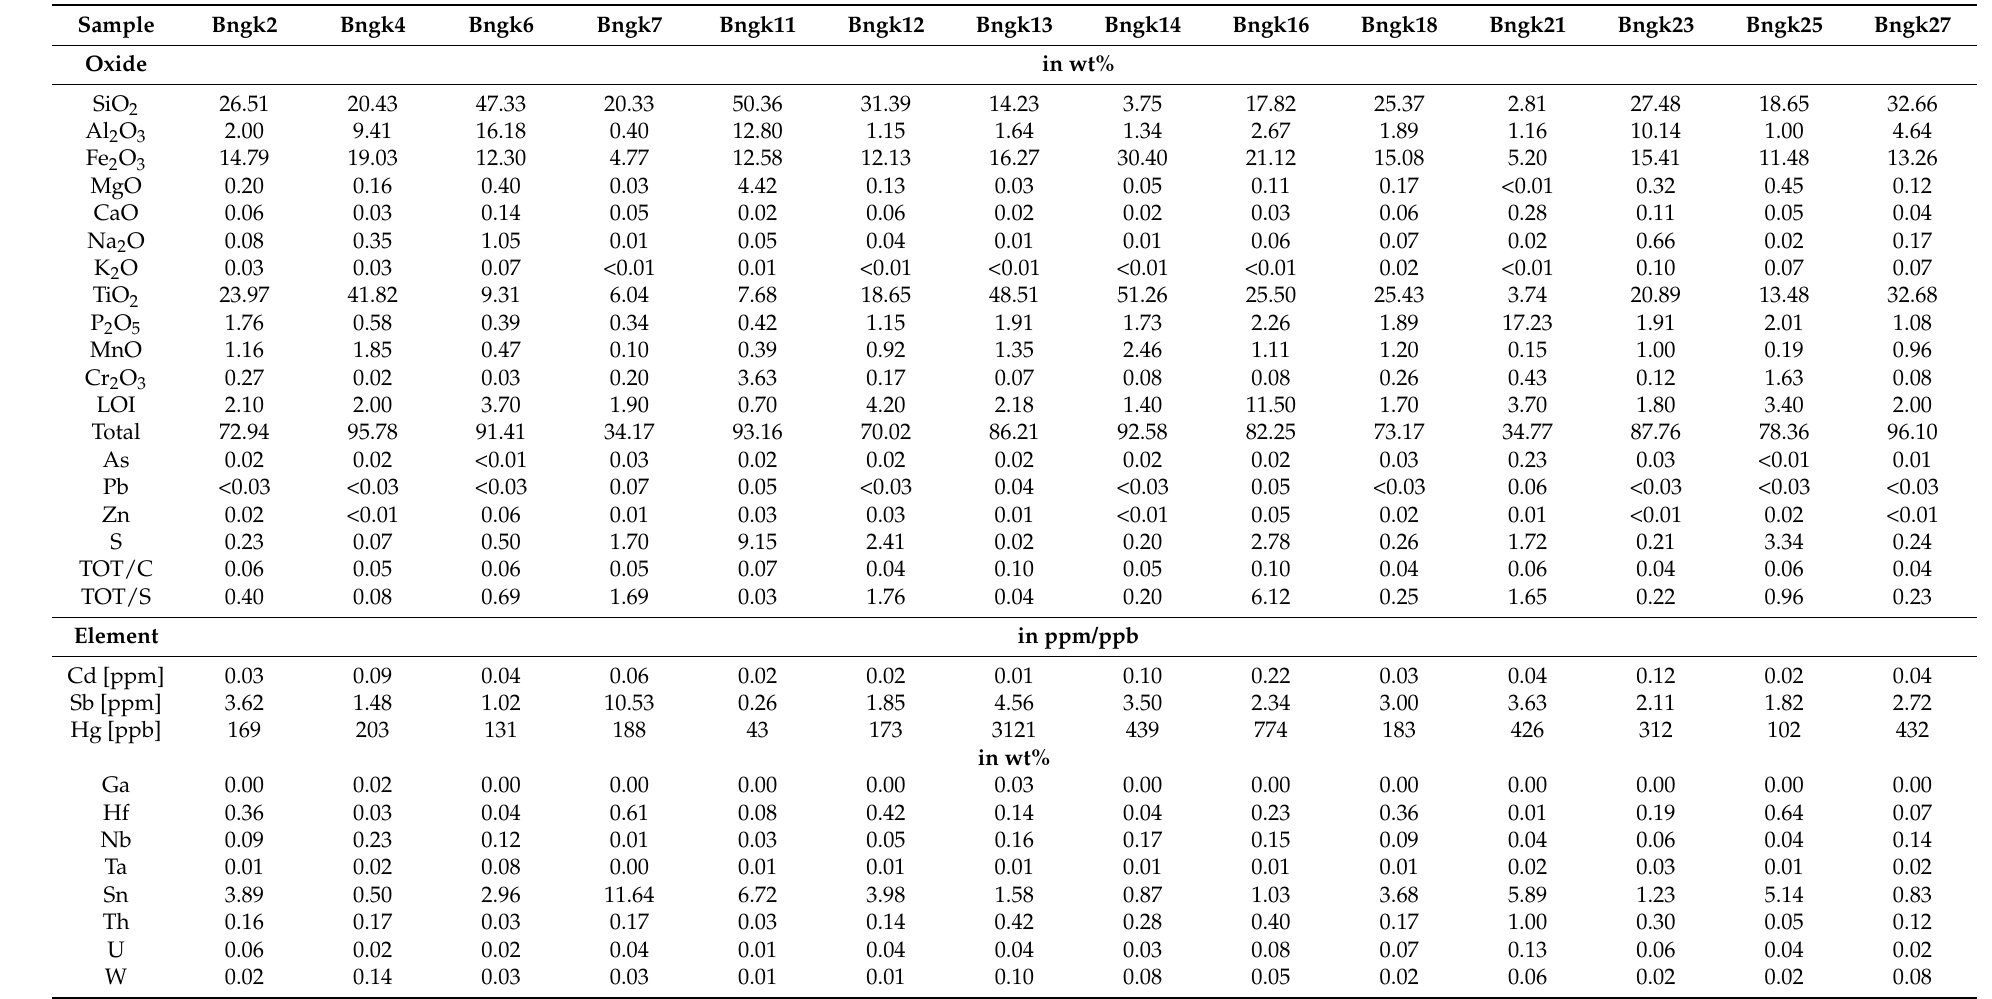
Table 1. Chemical results of selected tailing samples from Bangka Island. ICP-MS/ES